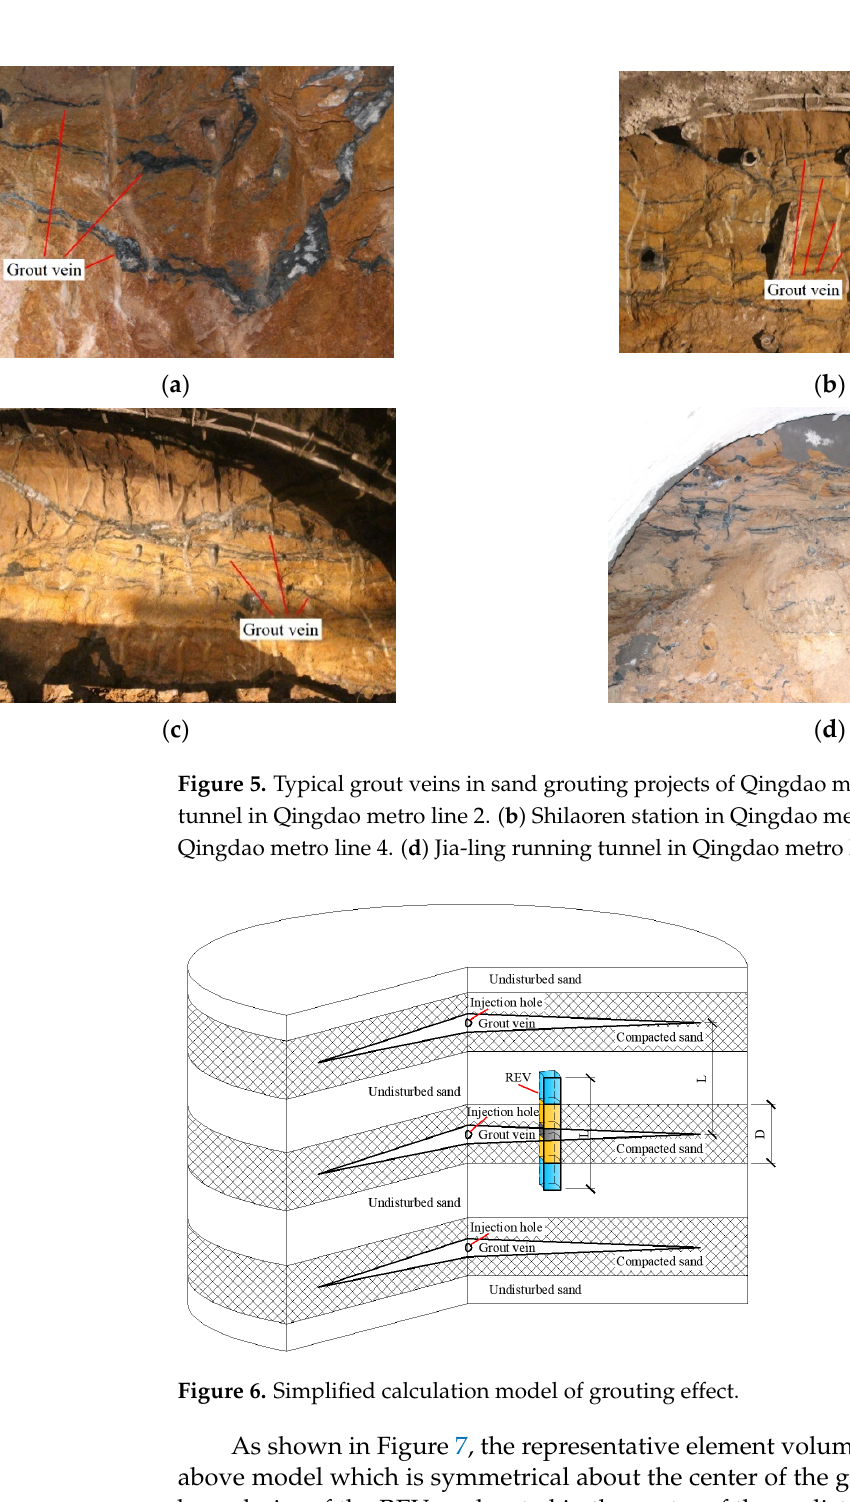
Figure 6. Simplified calculation model of grouting effect.